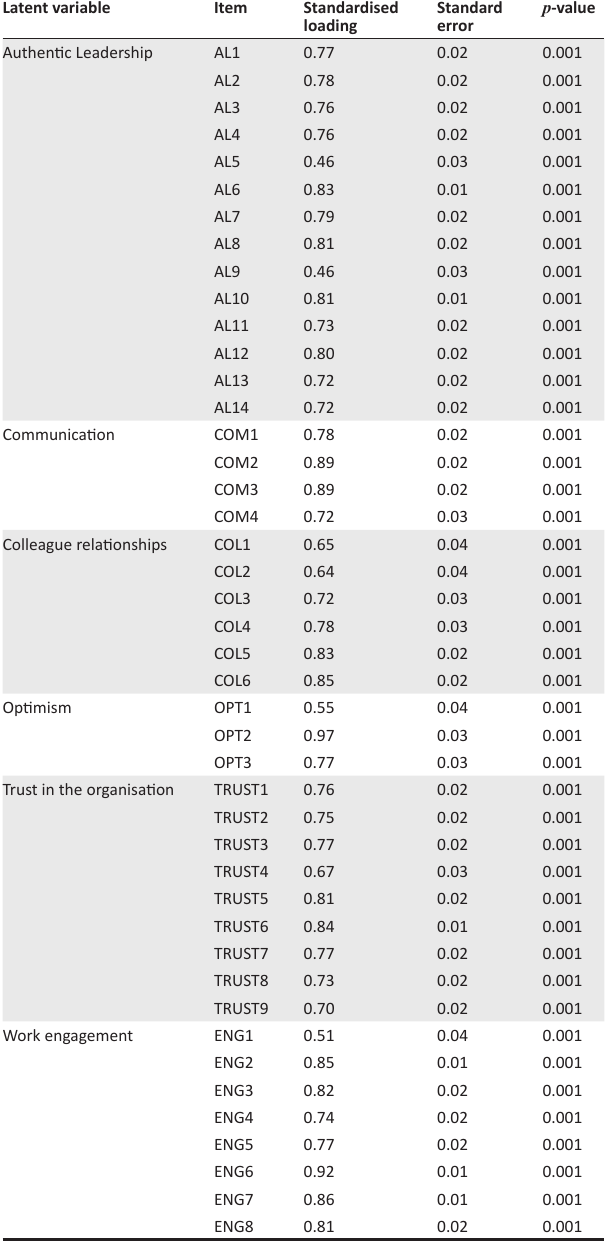
TABLE 1: Factor loadings for the latent